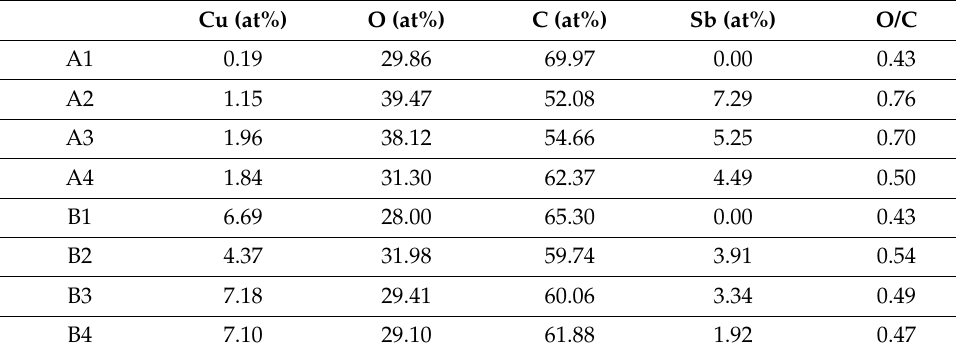
Table 2. Content of copper, oxygen, carbon and antimony in